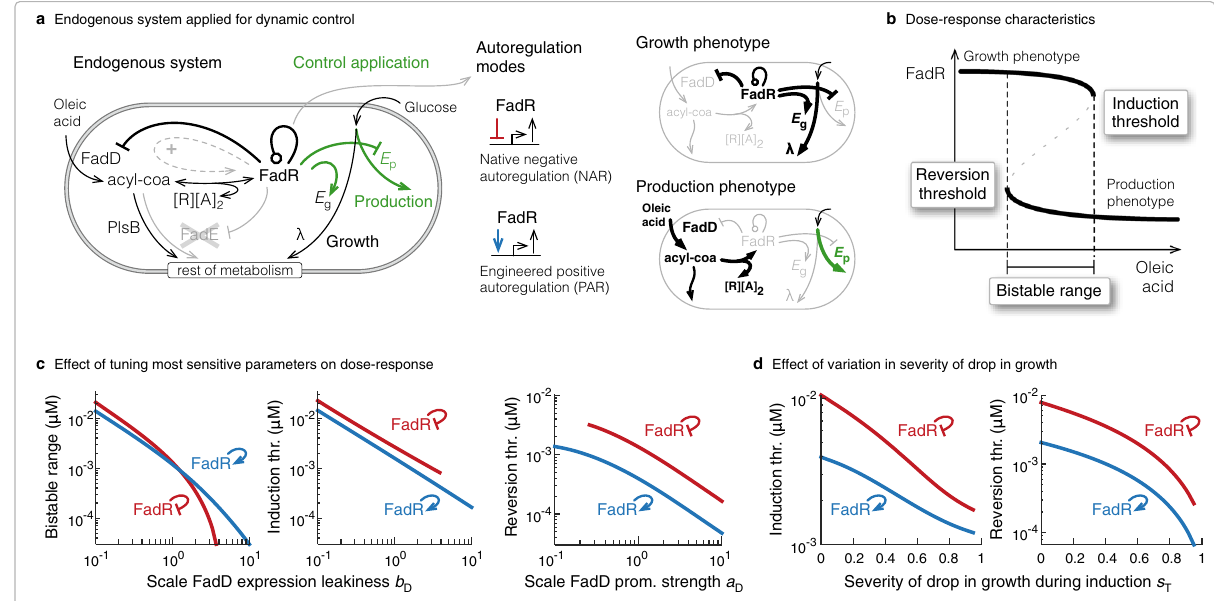
Fig. 1 Design of a robust bistable-switch. a Schematic of the endogenous regulation of fatty acid uptake in E. coli DH1 Δ fadE strain (black text and lines), and how its regulator FadR can be applied to control an oleic acid-induced switch from growth to production (green text and lines). Those components in high abundance in the absence and presence of oleic acid, i.e., growth and production phenotypes, are highlighted in bold in illustrations on right. We consider two ways FadR regulates its own expression: the native negative autoregulation (NAR) or engineered positive autoregulation (PAR). b Illustration of a dose-response curve and three features we measure to characterise the switch behaviour: induction threshold; reversion threshold and bistable range. c Plots of how the bistable range and induction threshold are affected by changes in FadD expression leakiness, and how the reversion threshold is affected by a change in FadD promoter strength, for the native system with NAR (red) and an engineered system with PAR (blue). Parameter were varied from 10 to 1000% of their nominal value from Supplementary Table 2. d Plot of how induction and reversion thresholds are affected by changes to the proportional drop in growth rate after